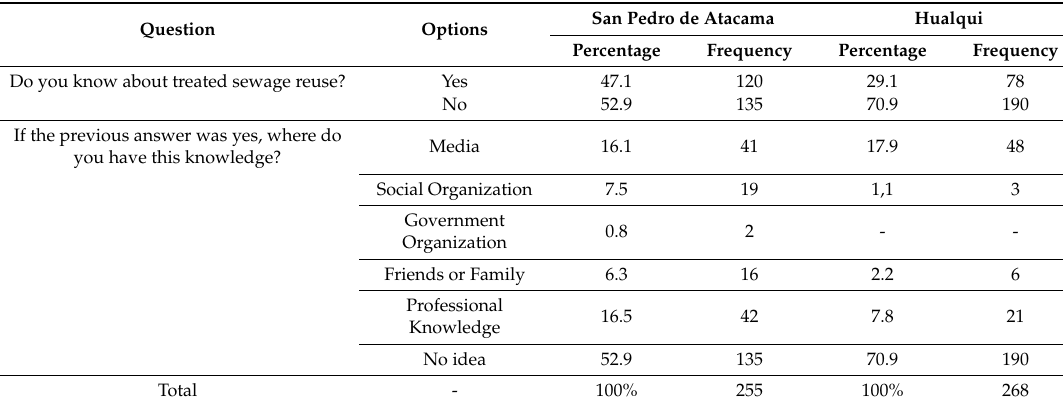
Table 5. Public knowledge with regard to treated sewage